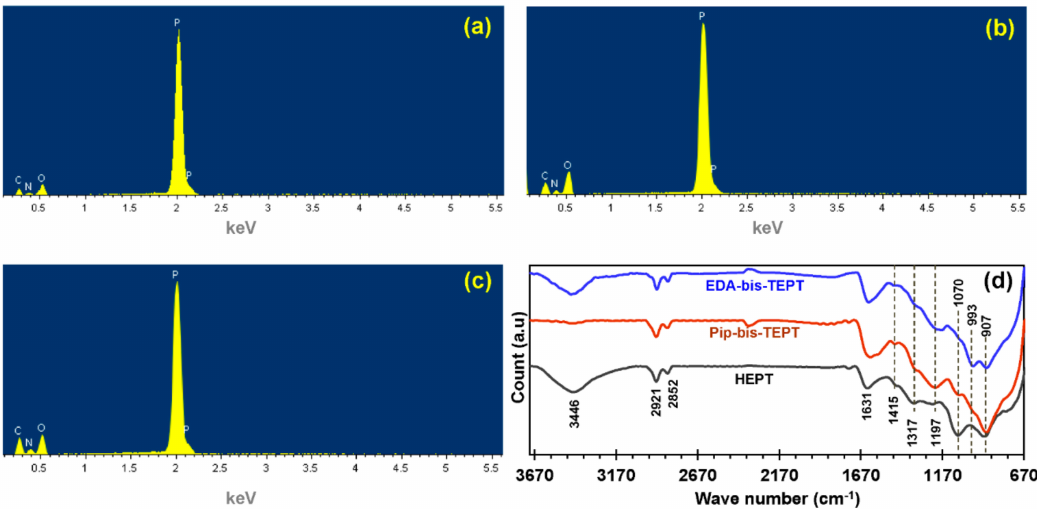
Figure 3. Energy-dispersive X-ray analysis (EDX) elemental composition of the char residue of HEPT ( a ), EDA-bis-TEPT ( b ), Pip-bis-TEPT ( c ), and the Fourier-Transform Infrared Spectroscopy (FTIR) spectra for their corresponding char residues ( d ). All of the char residues were obtained after the oxidative pyrolysis of the corresponding